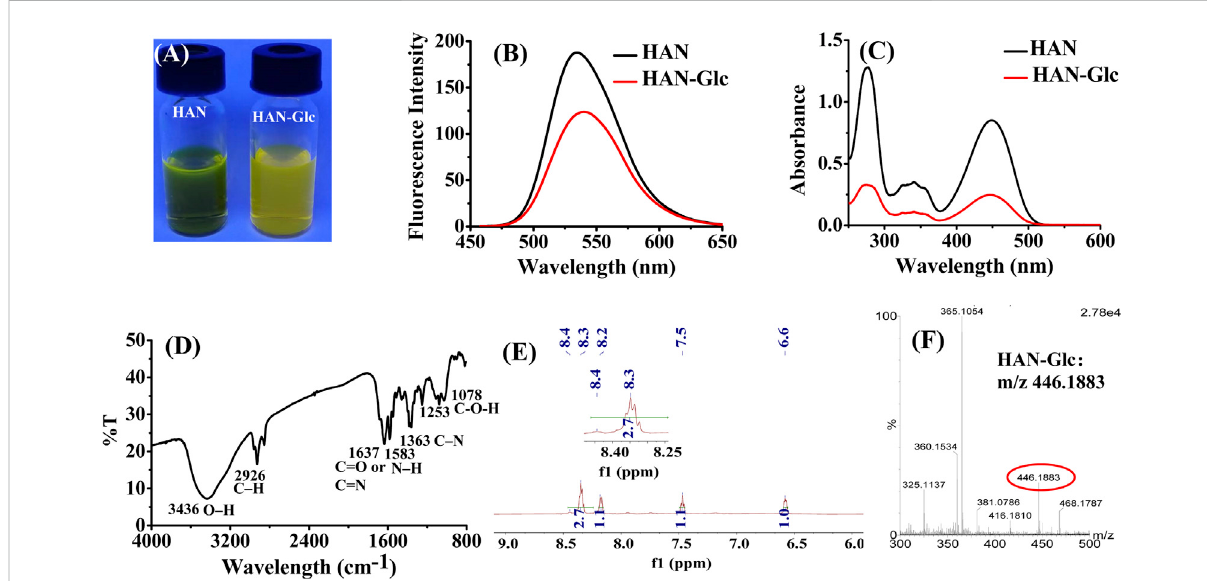
FIGURE 4 Mechanismanalysis: (A) FluorescencephotographofHANandHAN-Glcsolutionsunderawavelengthof365 nm; (B) fl uorescencespectrumof HAN and HAN-Glc; (C) UV-Vis spectrum of HAN and HAN-Glc, (D) FT-IR pro fi le of HAN-Glc, (E) NMR spectra of HAN-Glc, and (F) HRMS data of